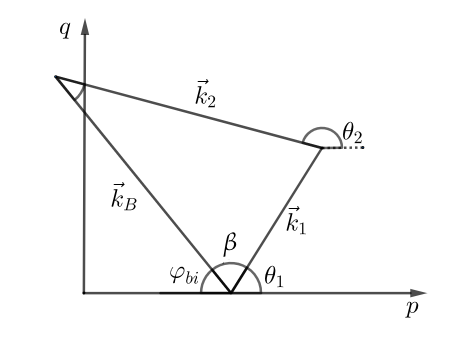
Figure 6. Geometry of the second order scattering wave vectors, (cid:126) k 1 and (cid:126) k 2 , at angles θ 1 and θ 2 ,